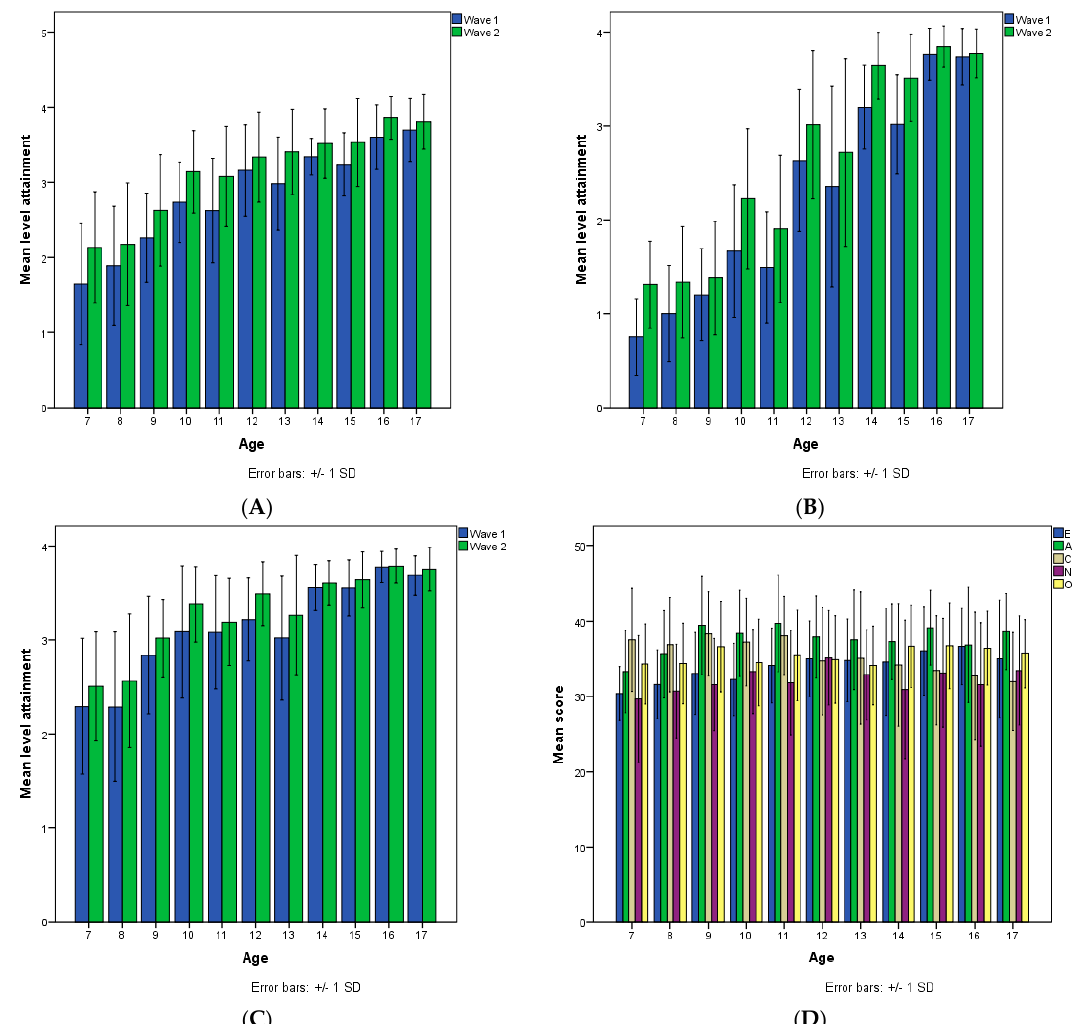
Figure 5. Mean level attainment in arithmetic, algebraic, and Raven reasoning (Panels A – C ) and personality (Panel D ) as a function of age and testing wave. ( A ) Arithmetic ability; ( B ) Algebraic reasoning; ( C ) Raven; ( D ) Personality traits.